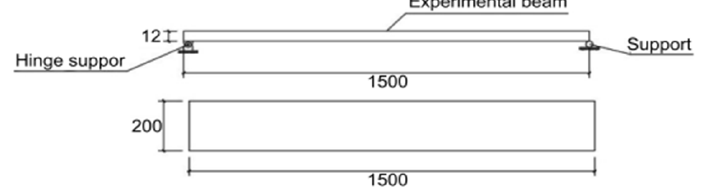
Figure 1. Schematic diagram of experimental beam models.